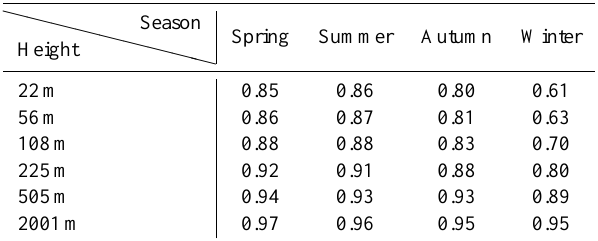
Table 4. Seasonal mean values of the sulfuric reaction ratio aver- aged from the ground up to different heights calculated according to Eq.